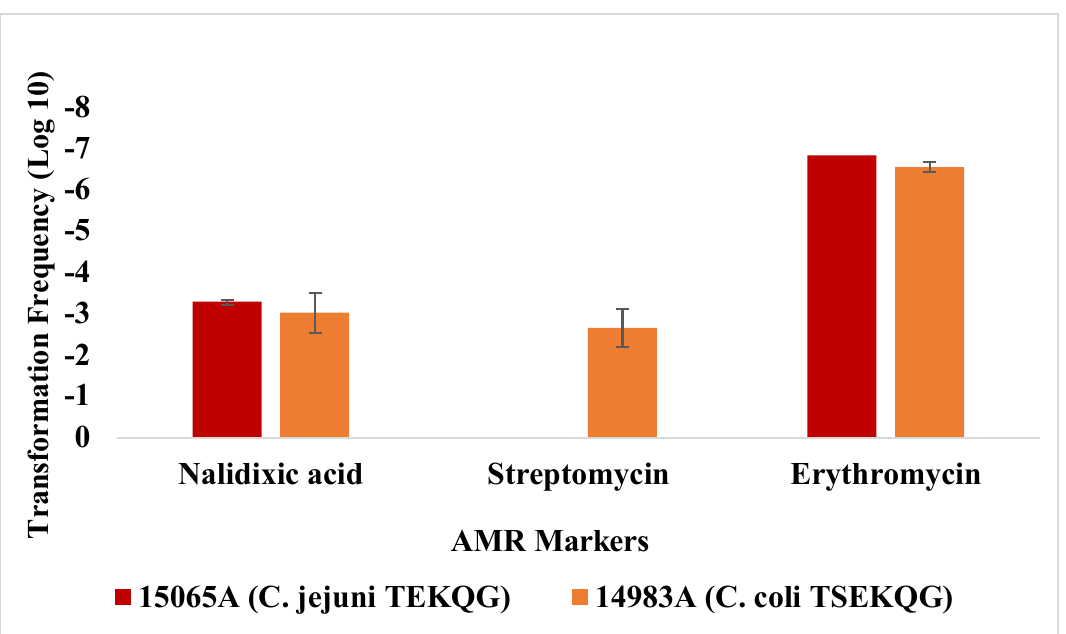
Figure 6. Transformation of C. coli N43850 to nalidixic acid, streptomycin, and erythromycin re- sistance. Transformation frequencies are averages from two or more independent trials for each recipient strain–donor DNA pair, and transformations were carried out as described in Materials and Methods. The error bar for transformation frequency to erythromycin resistance using DNA from C. jejuni 15065A was too small to be visible. Cj and Cc in front of strain designations indicate C. jejuni and C. coli , respectively. AMR phenotype designations in strain names are as in the legend to Figure 2.